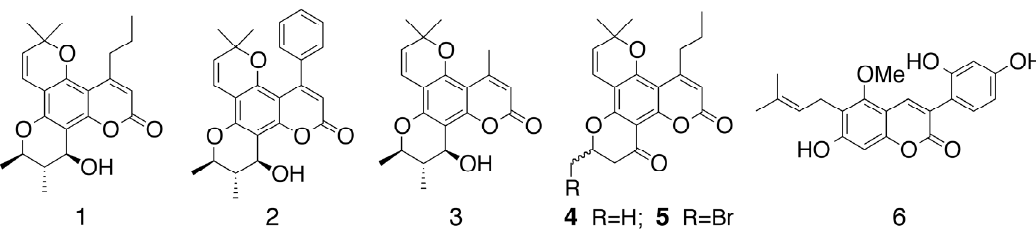
Figure 1. Natural and synthetic anti-VIH